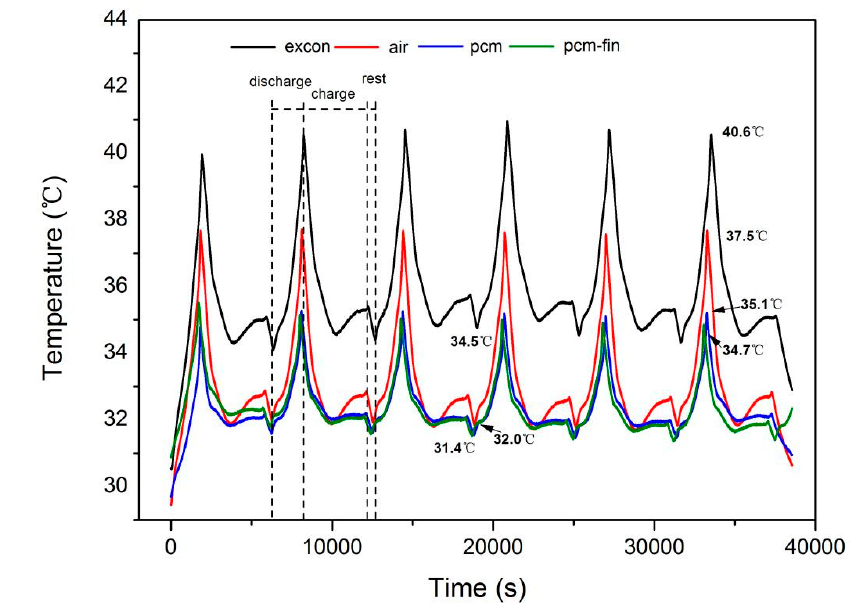
Figure 4. The temperature changes of LiFePO 4 battery during charging and discharging.